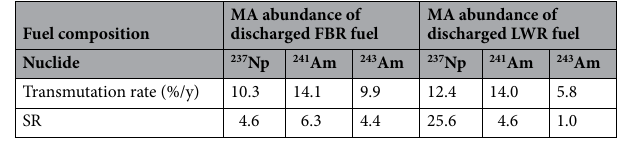
Table 1. Transmutation rate and support ratio of Mas.